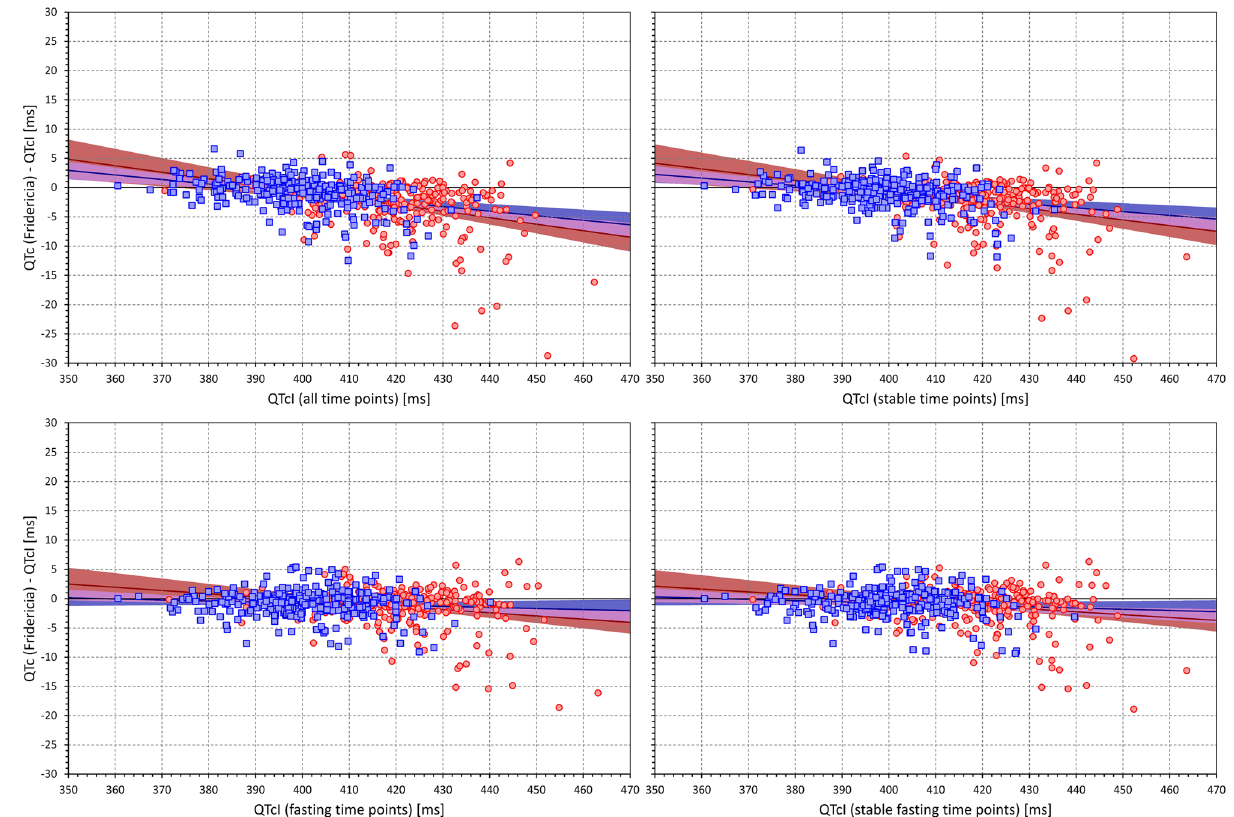
Figure 14. The figure meaning and layout correspond to those of Fig. 12 but instead Bazett QTc data, Fridericia QTc data were